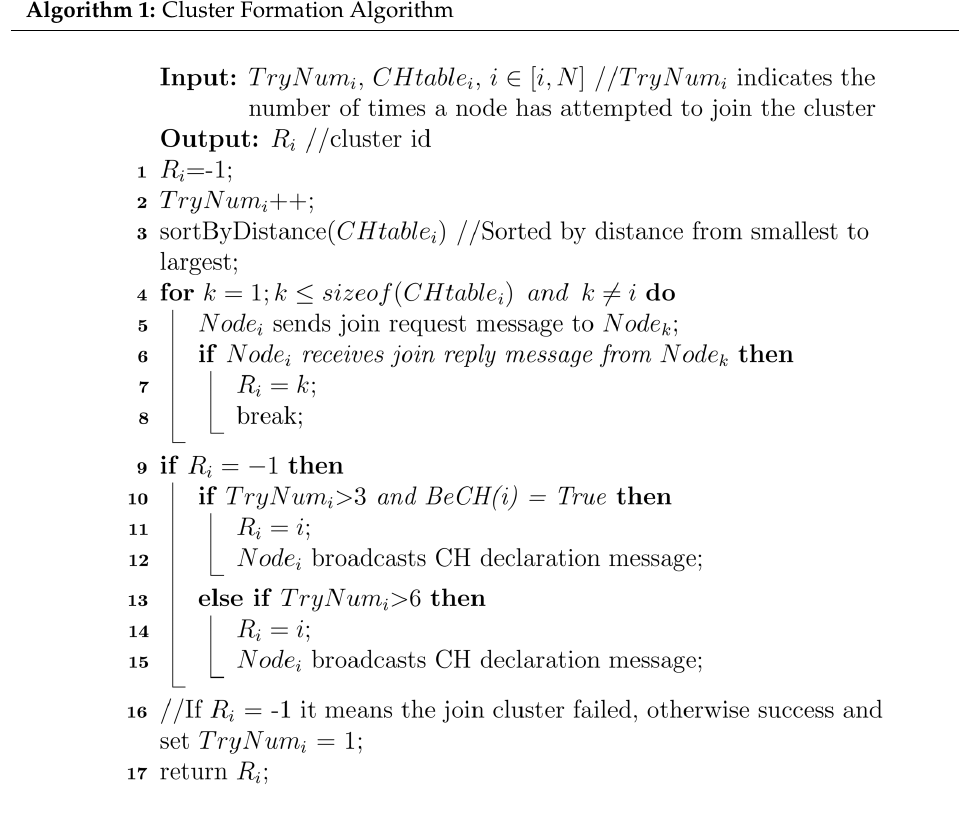
Algorithm 1: Cluster Formation Algorithm